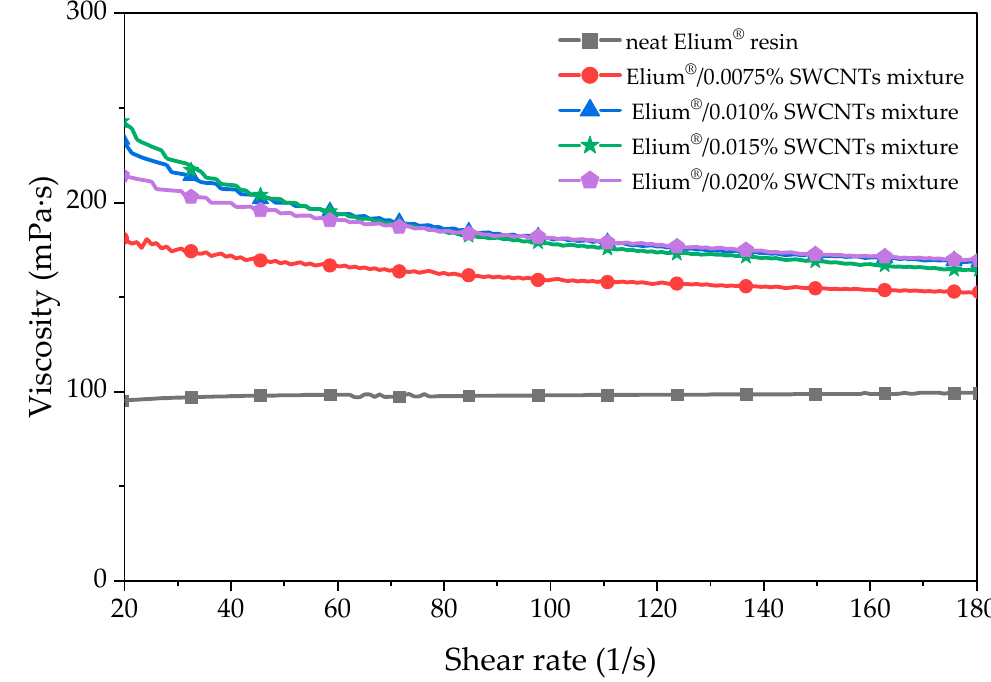
Figure 1. The viscosity of Elium ® /SWCNT mixtures after the ultrasonication process.